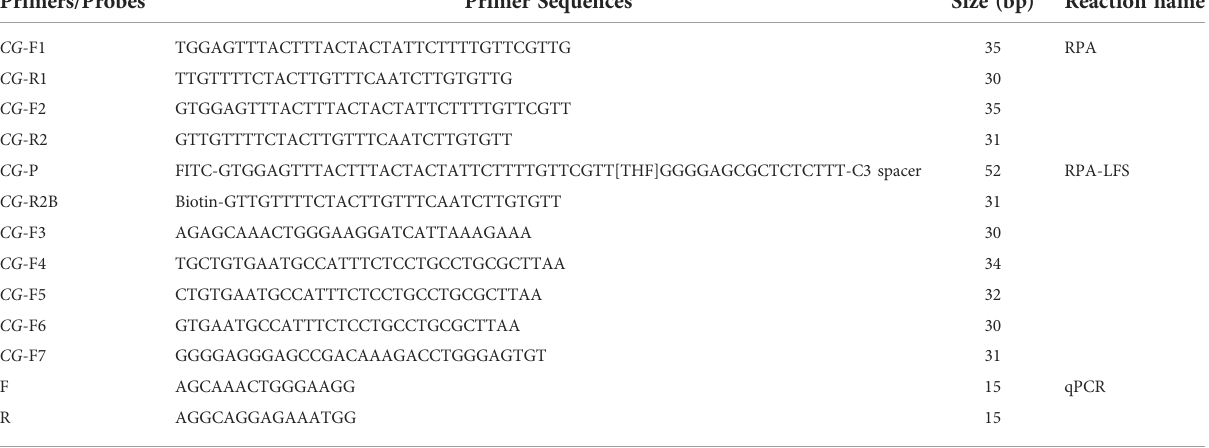
TABLE 1 Primers and